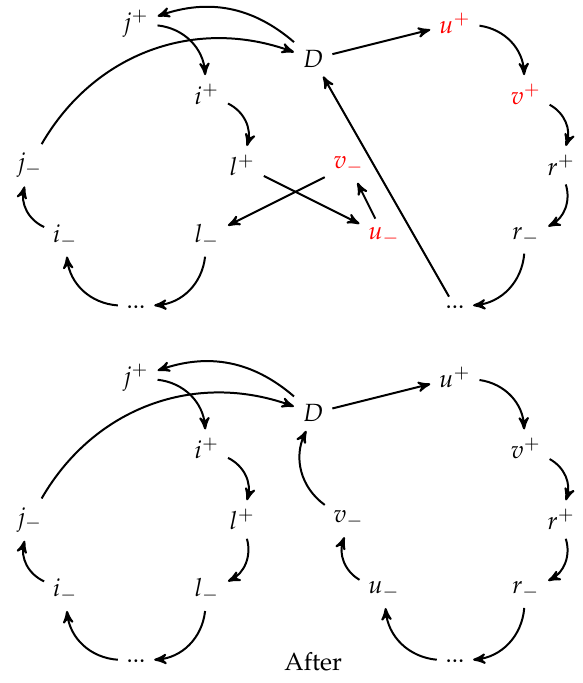
Figure 6. Repair-Destroy Inter-route